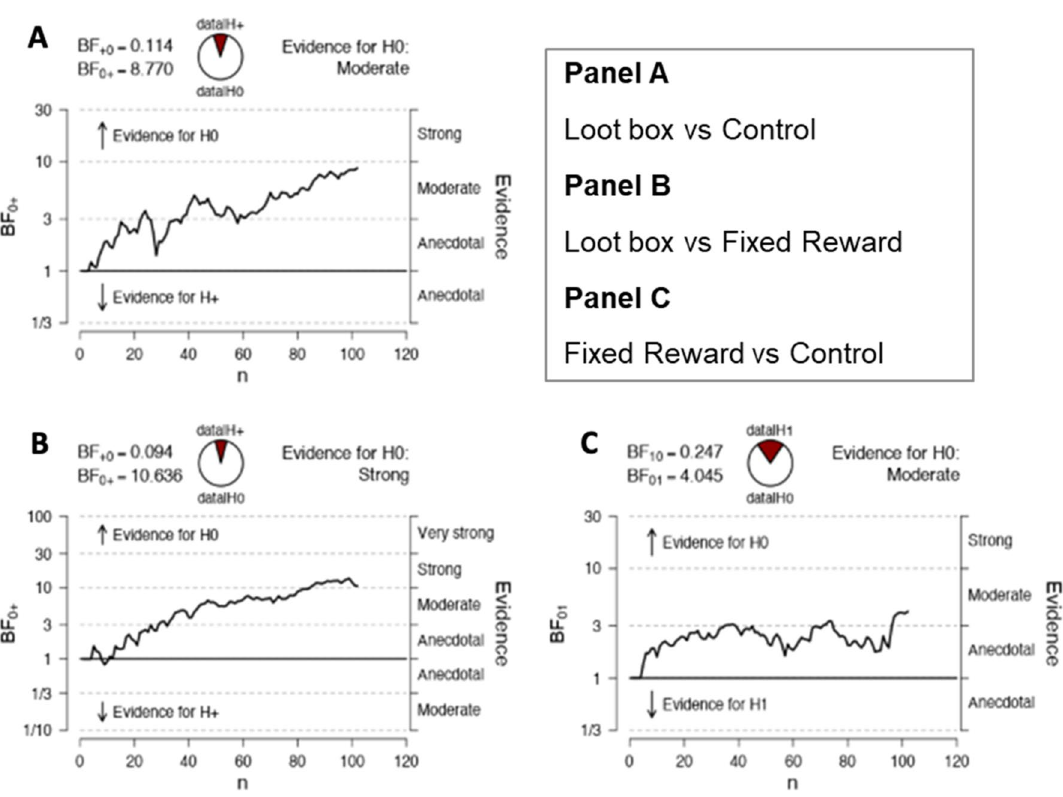
Figure 3. Sequential analyses for Bayesian